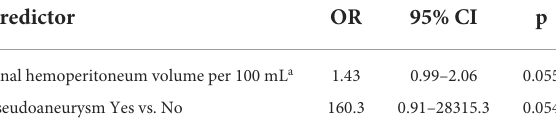
TABLE 3 Multivariable model of the relationship between predictor variables and splenectomy.